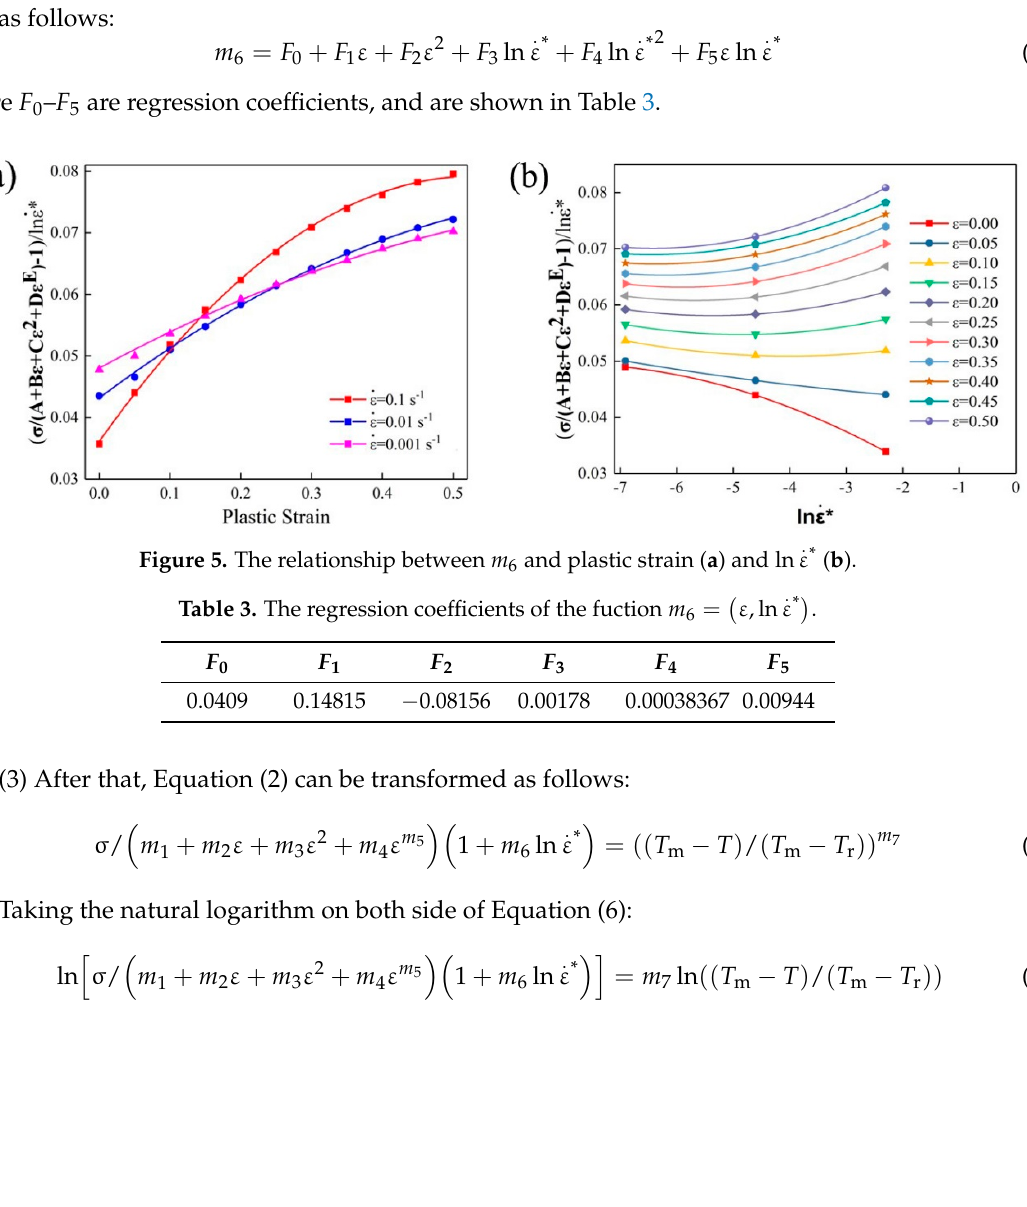
. ε * (cid:1) − 1 and ln .